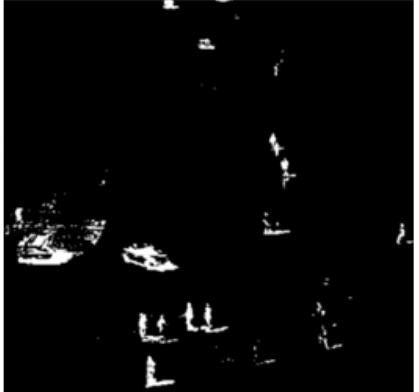
Figure 6 | four-state grayscale image that agents compute on